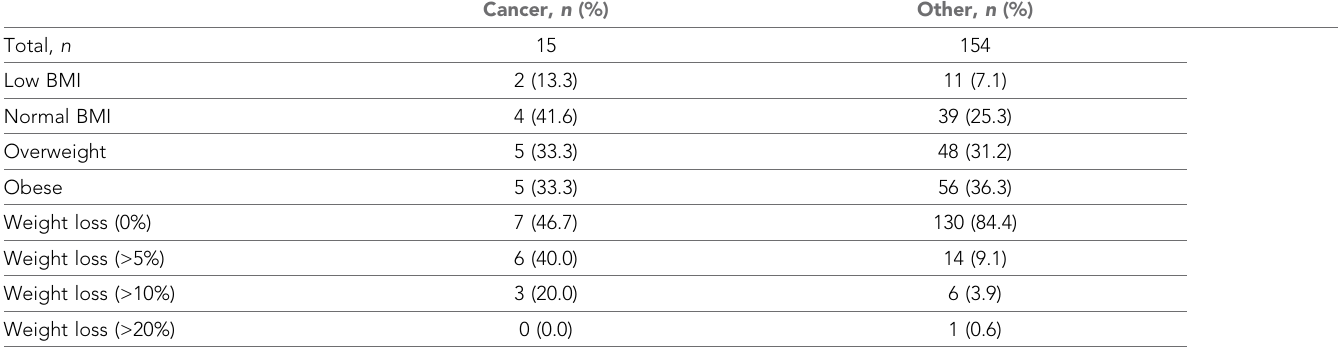
Table 3. Details of nutrition related to